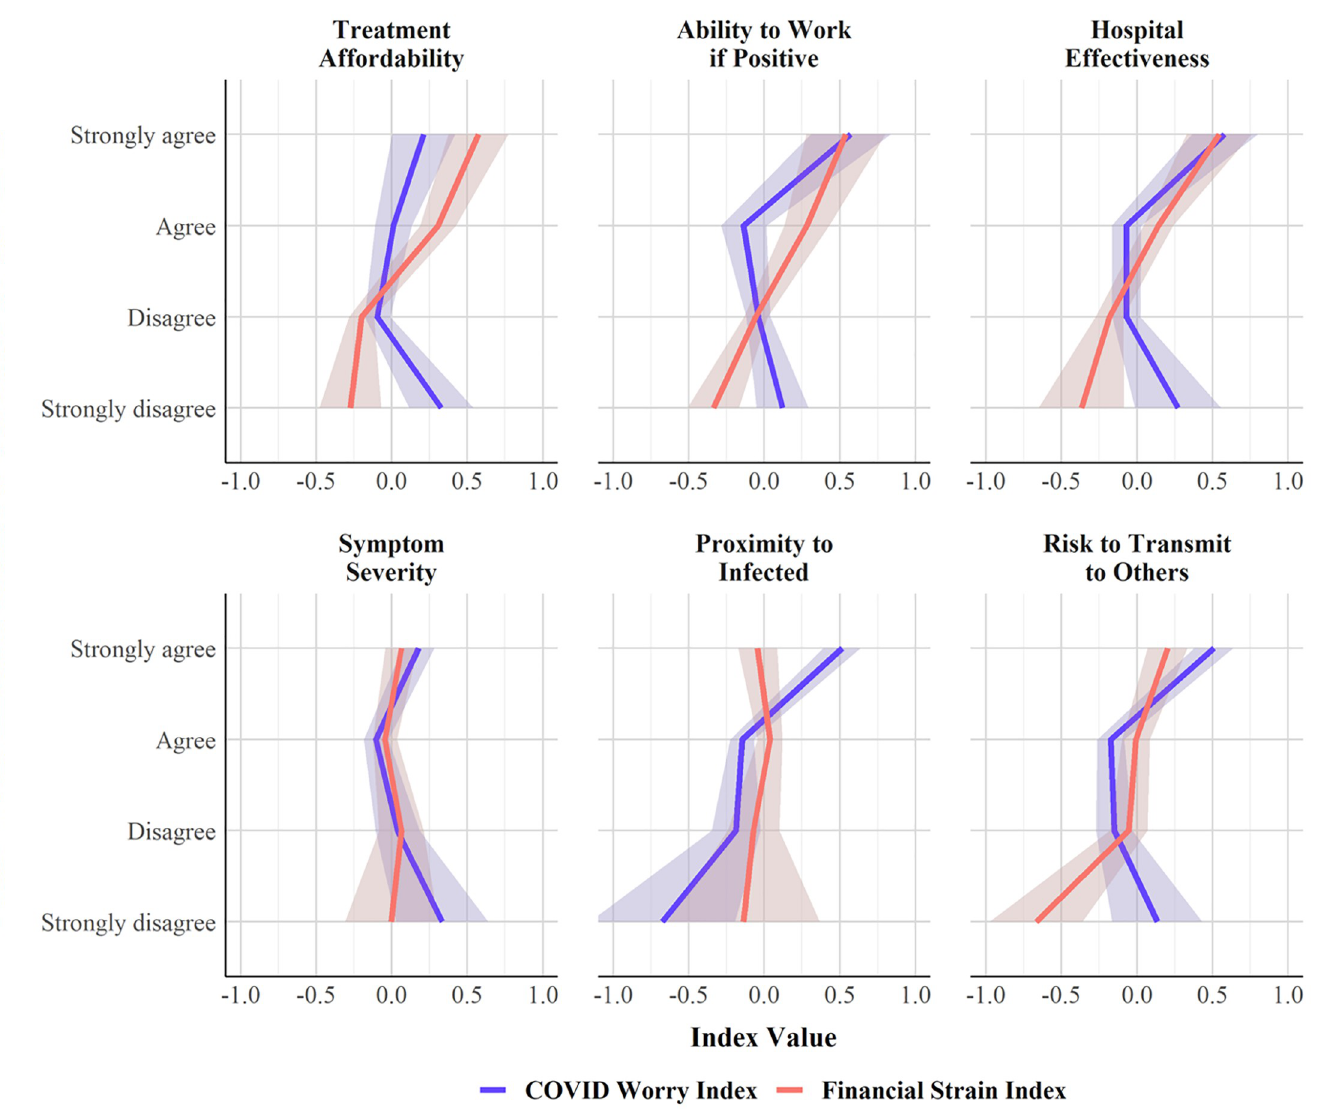
Fig 2. Association of COVID worries and financial strain with COVID-19 testing intentions.